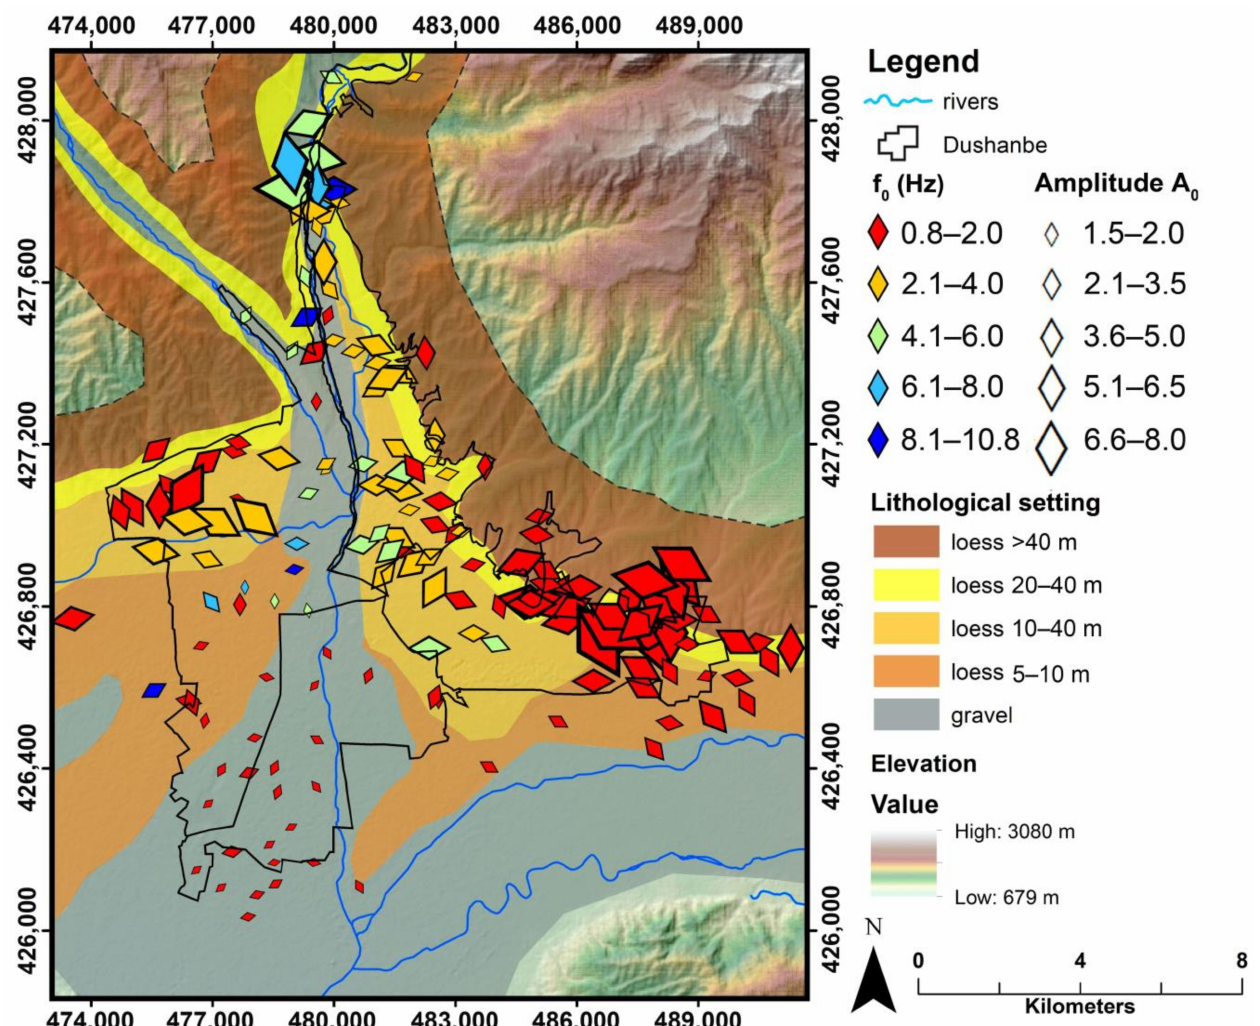
Figure 8. Results of the horizontal to vertical spectral ratios (HVSRs) analyses. Colors of lozenges indicate five different classes of fundamental frequency (f 0 ), the sizes of lozenges show the peak amplitudes (A 0 ), and the orientation of the long diagonals represents the